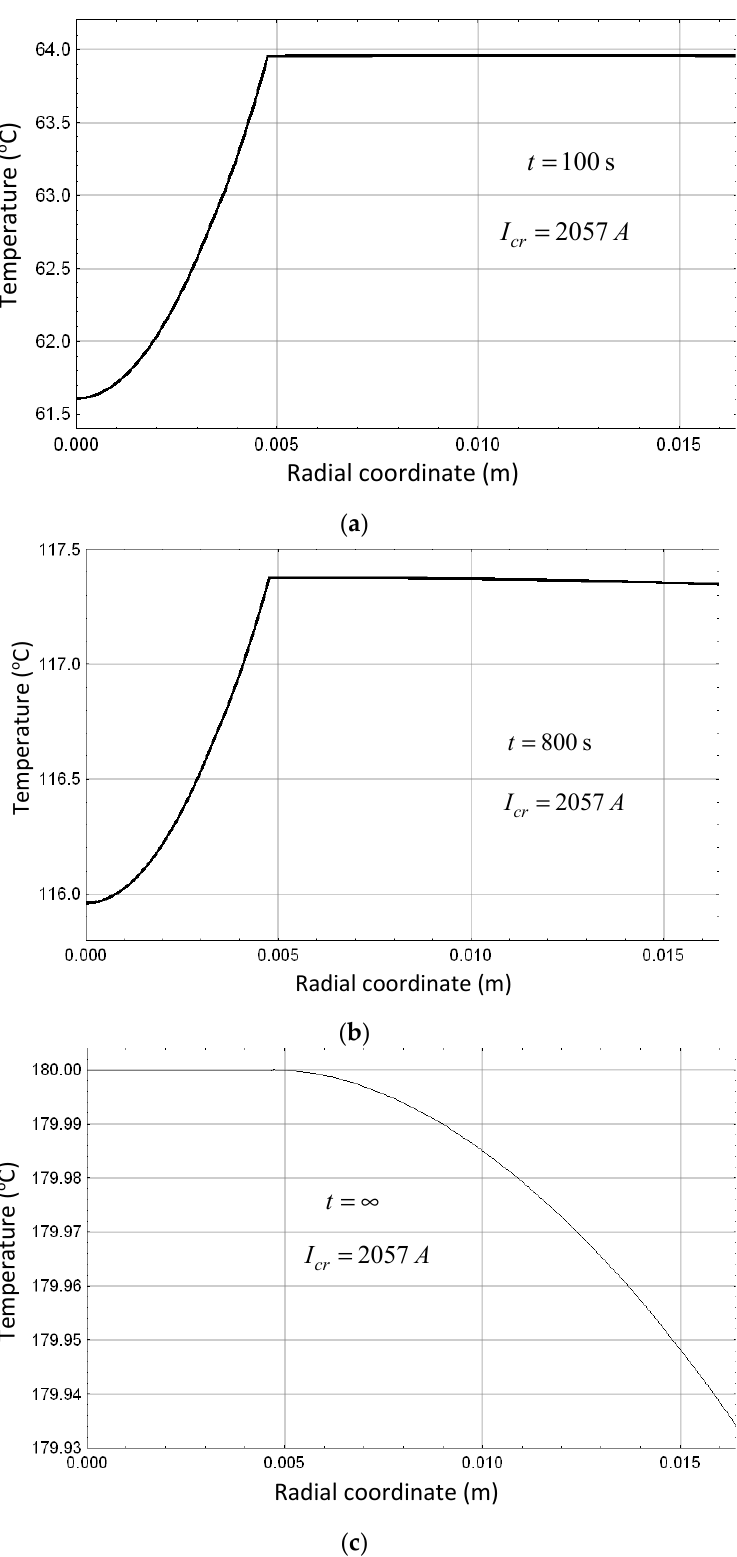
Figure 3. ( a ) Radial temperature distribution at the instant t = 100 s with the current load I cr = 2057 A, ( b ) radial temperature distribution at the instant t = 800 s with the current load I cr = 2057 A and ( c ) radial temperature distribution in the steady state ( t → ∞ ) with the load current I cr = 2057 A.